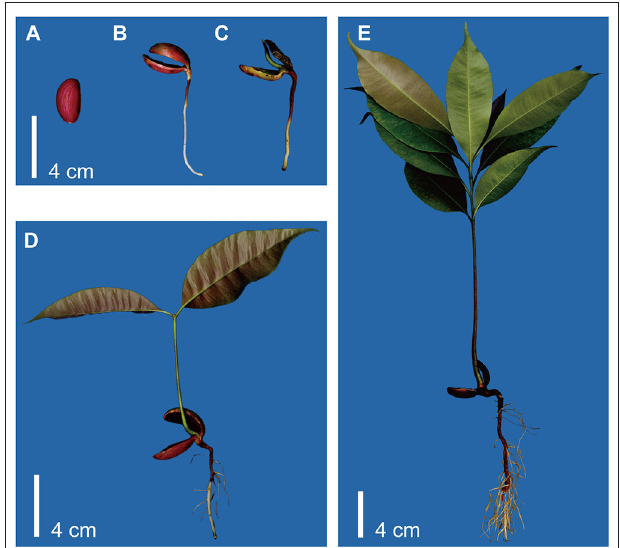
FIGURE 1 | Schematic representation of the experimental setup. (A) Stage 1: seed germination. (B) Stage 2: hypocotyl elongation. (C) Stage 3: epicotyl elongation. (D) Stage 4: two-leaf stage. (E) Stage 5: nine-leaf